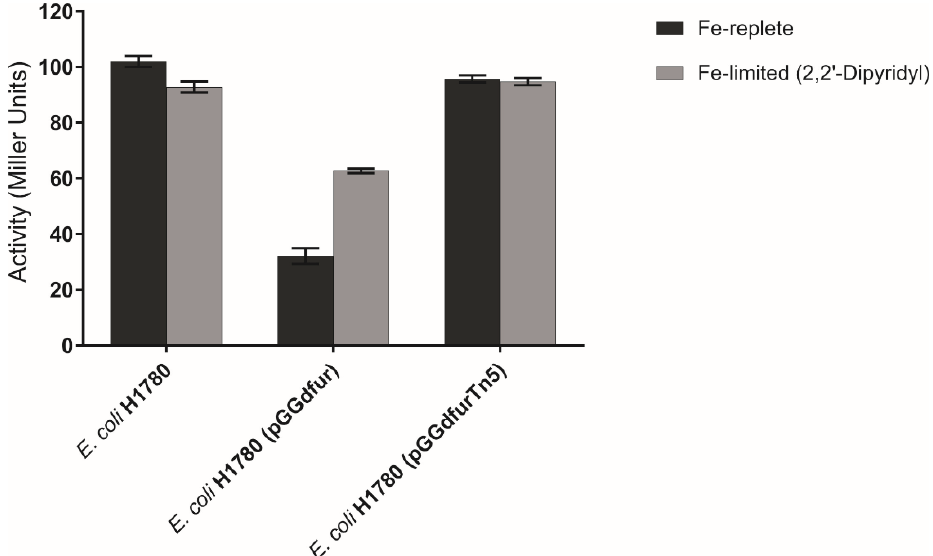
Figure 9. β -Galactosidase activity of E. coli H1780 cells containing the indicated plasmid and grown in M9 minimum medium liquid supplemented with iron and with low iron availability through the addition of 2,2 ′ -DIP. All determinations are the means of at least three experiments (each in triplicate).